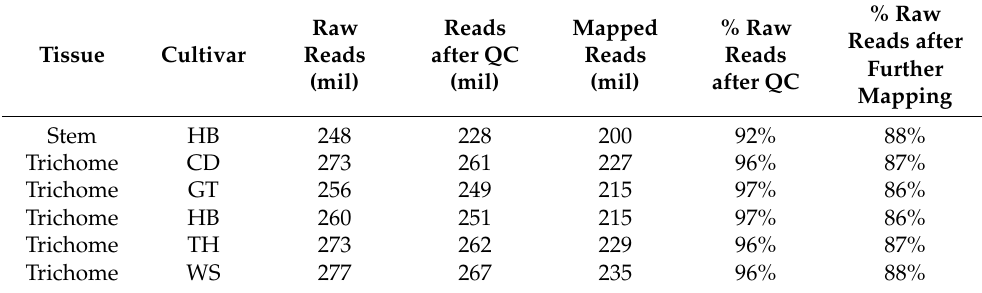
Table 1. RNA-seq read